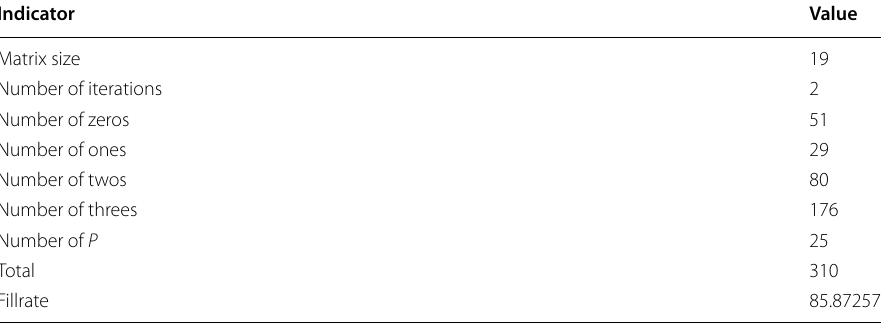
Table 7 Matrix characteristics of MicMac components